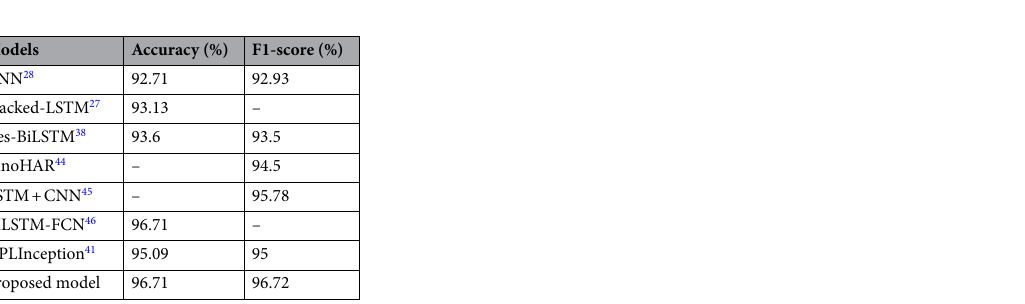
Table 7. Performance comparison of the proposed model with various DL-based models on the UCI-HAR dataset.